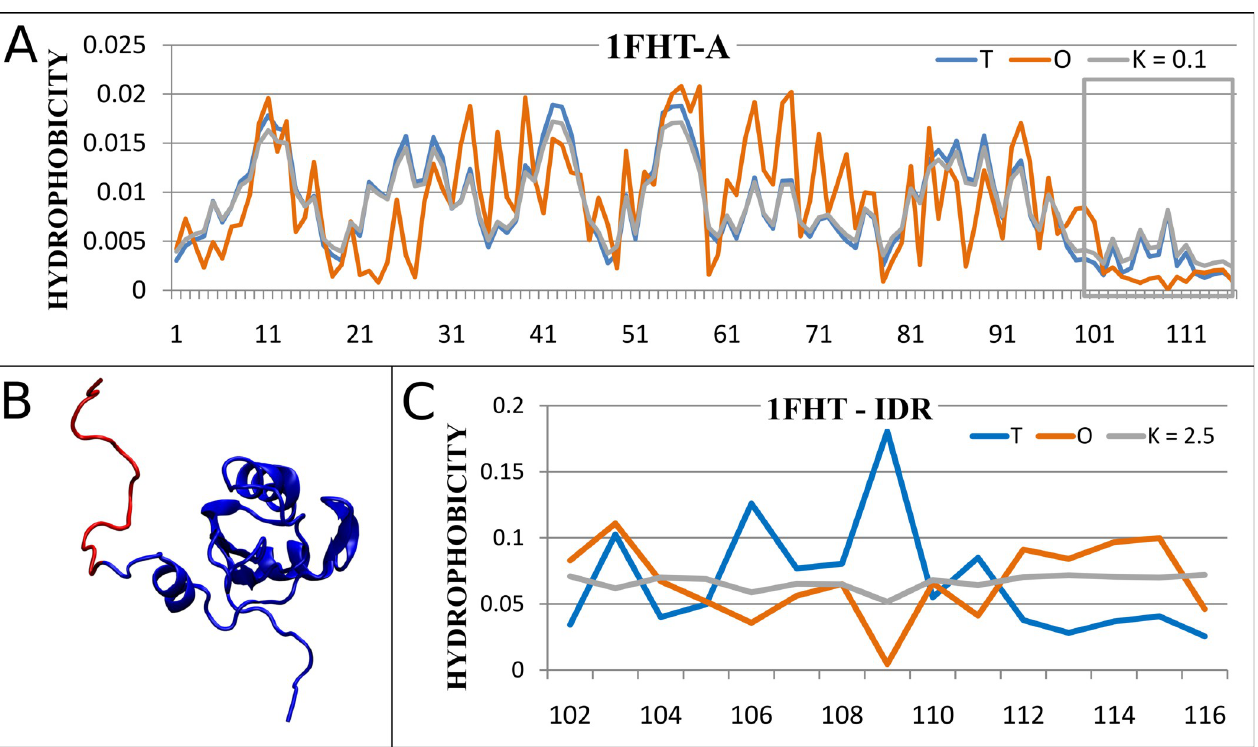
Fig 4. RNA-binding domain of the U1A spliceosomal protein (PDB ID 1FHT). A—the distributions T , O and M (corresponding to optimal K = 0.1) in whole structural unit (marked in blue, orange and gray respectively), IDR denoted by a box; B– 3D structure with IDR marked in red; C–the distributions T , O and M (corresponding to the optimal K = 2.5) in